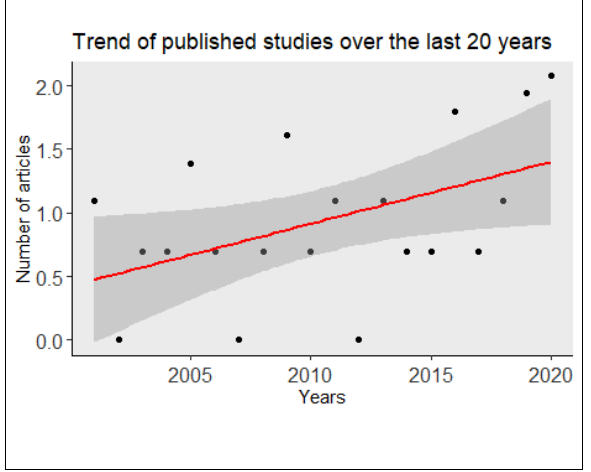
Figure 2: Trend of publications on the chemical pollution effects on the biota of Eastern Africa during the last 20 years.